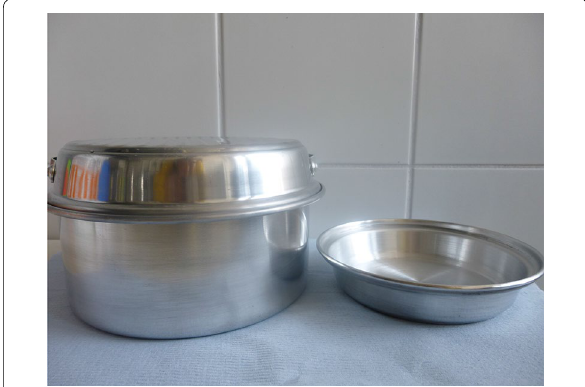
Fig. 2 Pot with lid and pan made of aluminum were obtained from a supplier of trekking